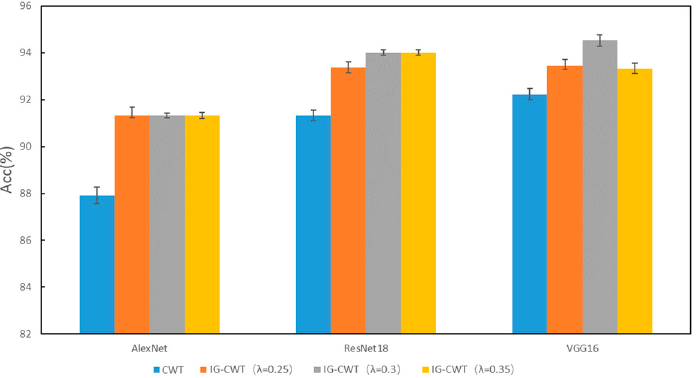
Figure 5. MFPT accuracy of IG ‐ CWT and CWT.